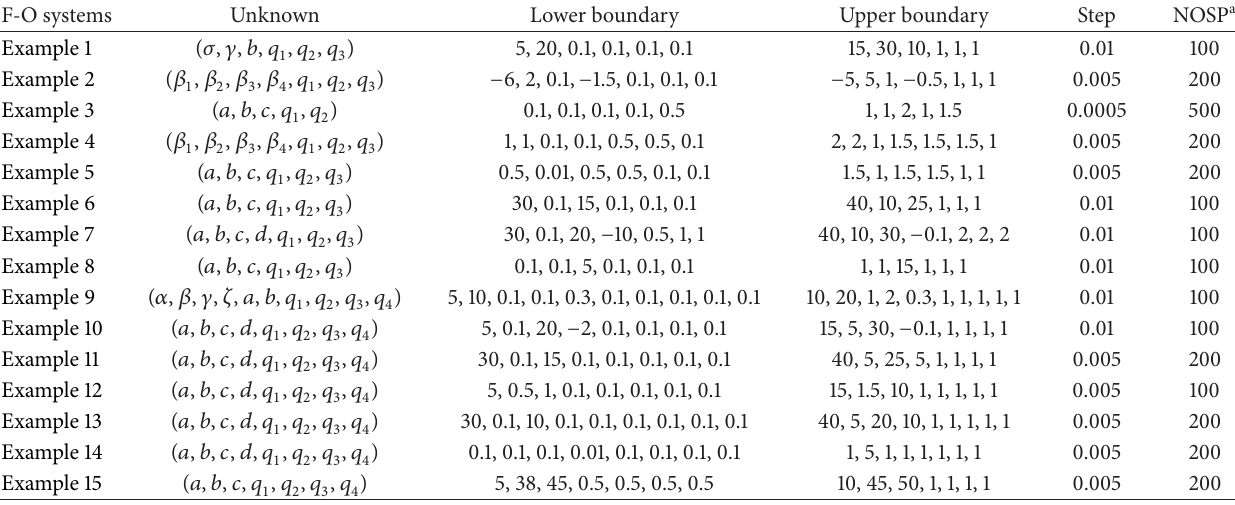
a Number of sample points for resolving the fractional chaos